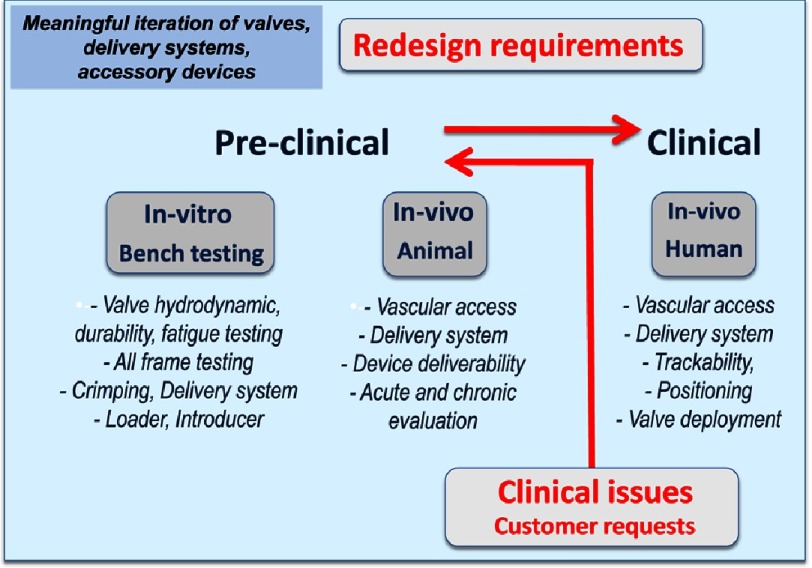
The translational pathway of transcatheter aortic valve replacement: driving for superior outcomes.